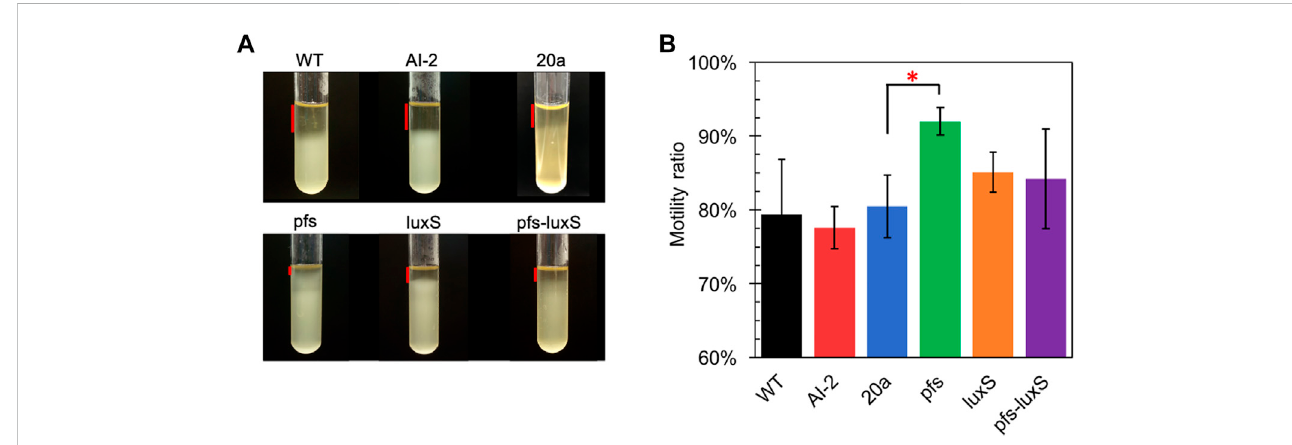
FIGURE 4 Motility test of Z. mobilis strains by settlement method (A) The cell sedimentation in the tubes (B) Motility ratio = 1-the height of the transparent part/the height of the entire medium. WT: wildtype. All transformants are constructed from ZM4. Three replicates. * represents p -value <